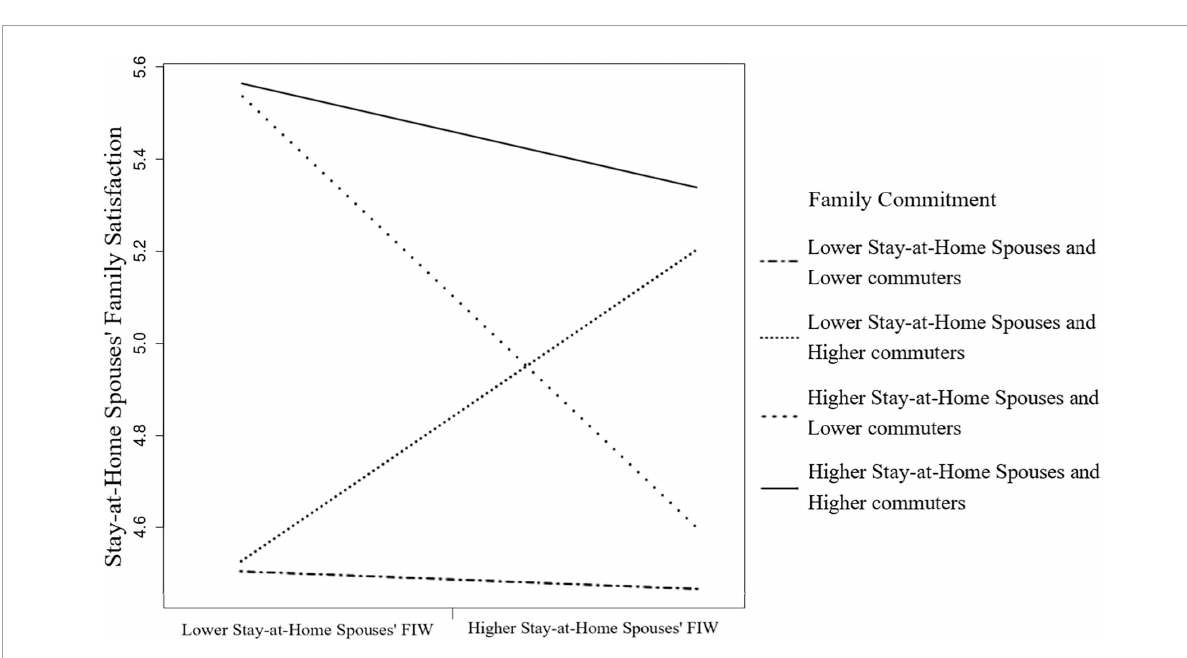
FIGURE5 Four combinations of family commitment on stay-at-home spouses’ FIW and family satisfaction